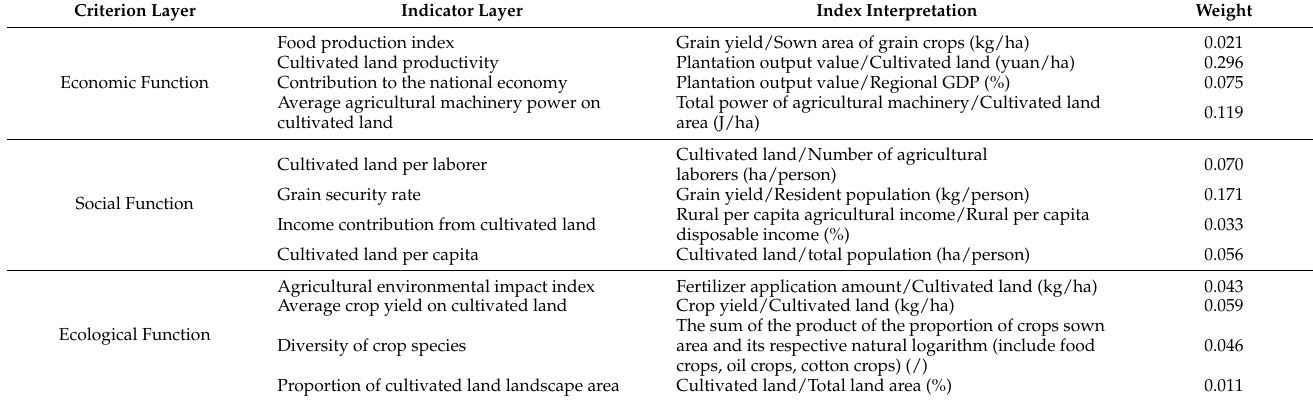
Table 1. The evaluation index system of recessive cultivated land use